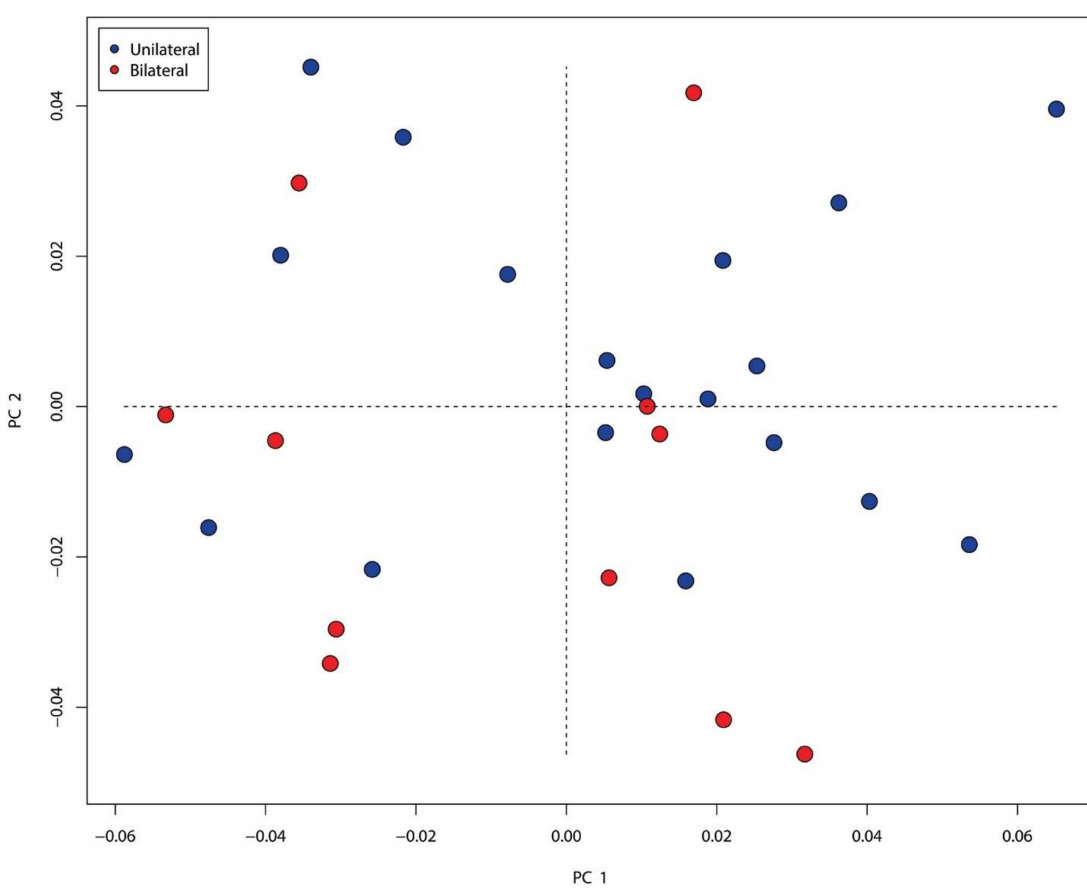
Figure 4. Plot of the first two PC axes from principal component analysis, which explains 32.0% of shape variance in the nsCLP subgroup. BCLP are indicated in red and UCLP are indicated in blue. There is no separation between the two cohorts, demonstrating that craniofacial skeletal shape variation does not di ff er in the presence of a unilateral or a bilateral cleft lip /